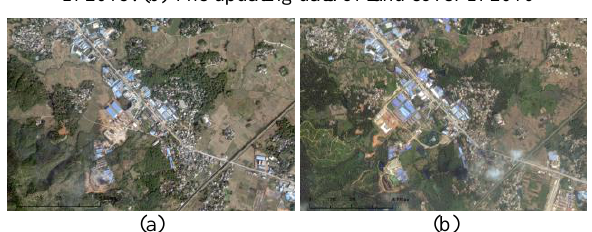
Figure 3. The results of land cover data. (a) The land cover data in 2015. (b) The updating data of land cover in 2016